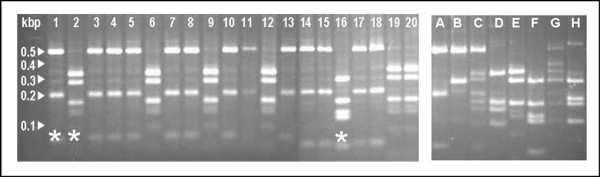
Representative PCR-RFLP profiles of the URA5 gene of 20 Cryptococcus isolates and 8 control strains A - H. Footnote: A = VN1, B = VN2, C = VN3, D = VN4, E = VG1, F = VG2, G = VG3, H = VG4 * denotes examples of detected molecular groups.